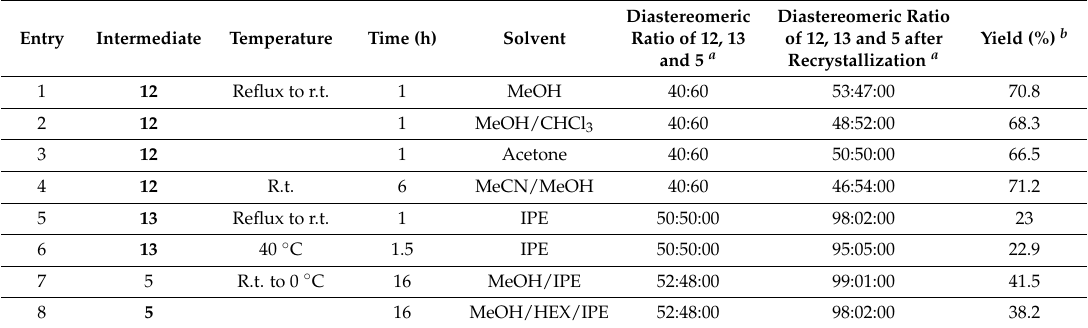
Table 1. Recrystallization of intermediates 12 , 13 and 5 .